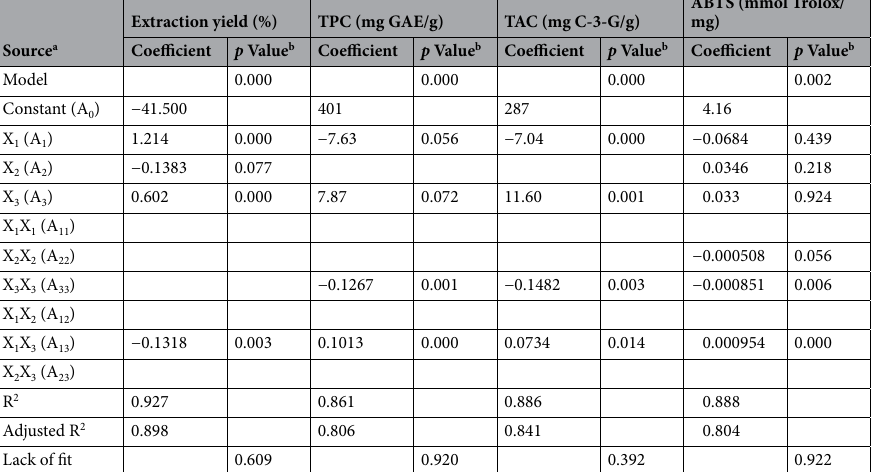
Table 2. Regression coefficients (A) of the independent variables, coefficient of determination (R 2 ) and lack of fit of the backward second-order polynomial regression models. a X 1 , X 2 and X 3 represented the temperature (°C), extraction time (min) and ethanol concentration (% v/v), respectively. b p value more than 0.05 is not significantly different at 5% level. TPC total phenolic content, mg GAE/g milligram gallic acid equivalents per gram extract, TAC total anthocyanin content; mg C-3-G/g milligram cyanidin-3-O-glucoside per gram extract, ABTS 2,2 ′ -azino-bis-3-ethylbenzothiazoline-6-sulphonic acid, mmol Trolox/mg millimole Trolox equivalents per milligram extract.